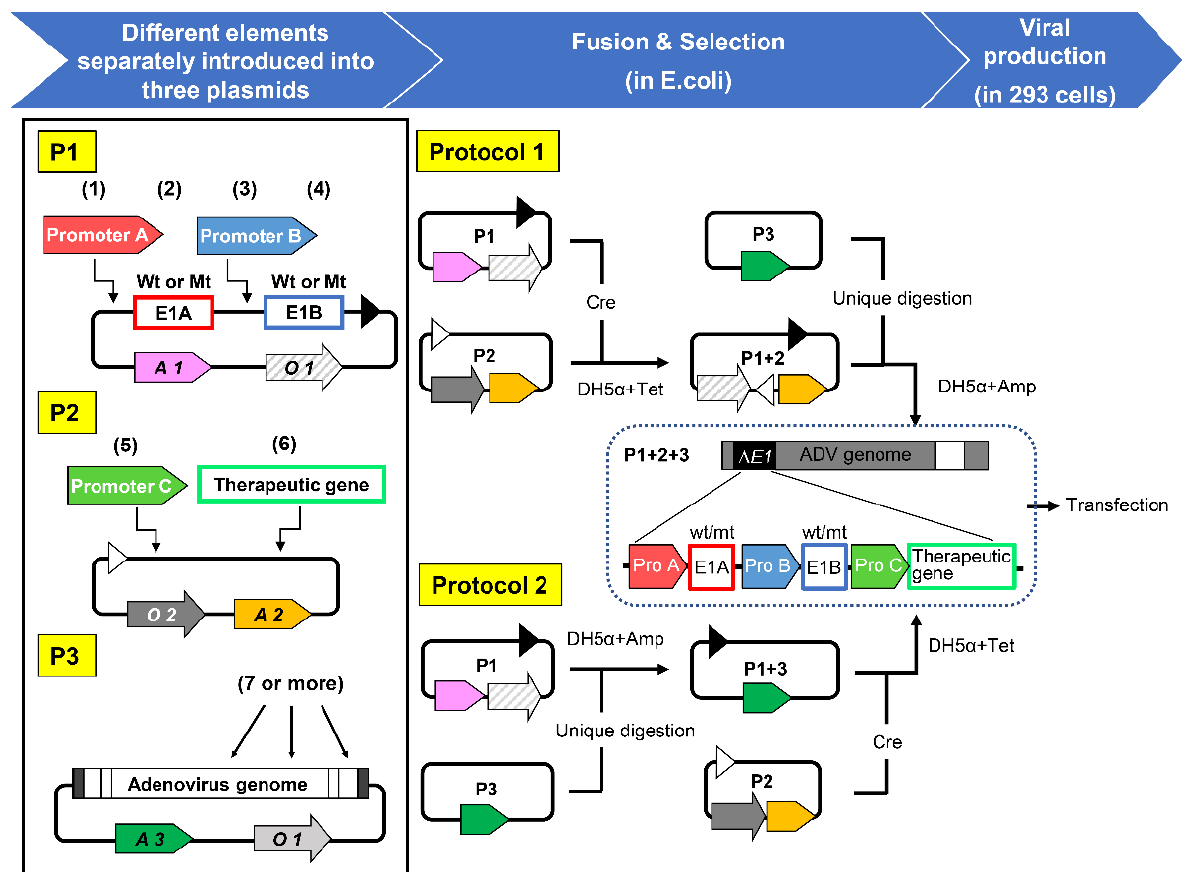
Figure 2. Constitution of m-CRA plasmids. Potentially, more than seven cancer-specific factors can be introduced into m-CRA. (1) Promoter A, which drives wild-type or mutant E1A expression. (2) Mutant E1A, which lacks an Rb-binding site (E1A ∆ 24). (3) Promoter B, which drives wild-type or mutant E1B. (4) Mutant E1B, which lacks a p53-binding protein that is encoded by E1B55K (E1B ∆ 55K). (5) Promoter C, which controls a therapeutic gene. (6) A therapeutic gene (seven or more can be incorporated). Modification of the adenoviral backbone is also possible, such as fiber modification to alter infectivity. A, antibiotic resistance gene; O, origin of replication.